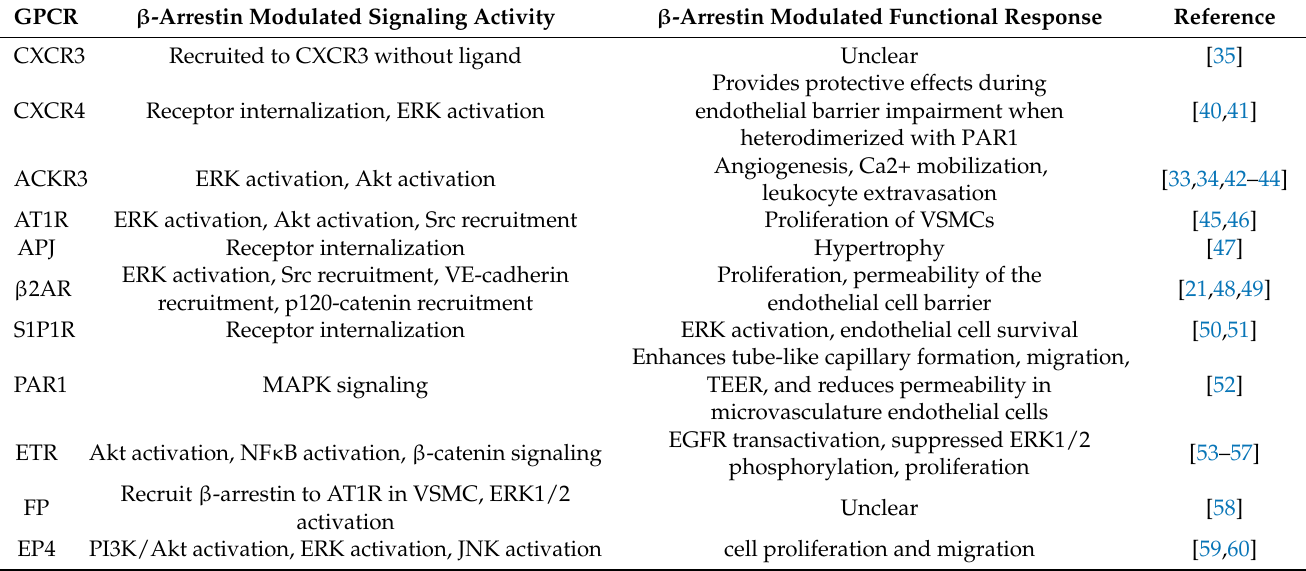
Table 1. Summary of β -arrestin-mediated signaling at selected GPCRs in endothelial cells.